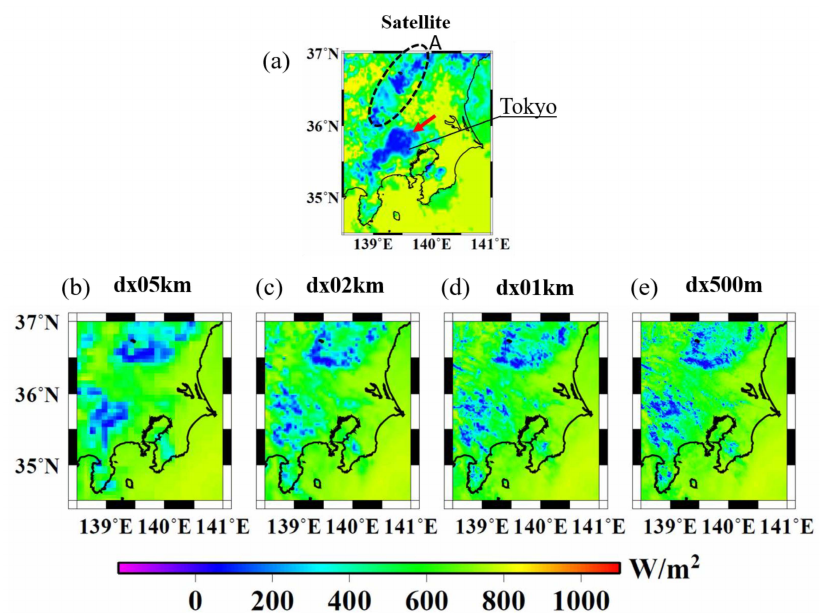
Figure 8. Comparison of the GHI horizontal distributions between the satellite observations and simulations. ( a ) Satellite-derived GHI distributions for the TEPCO area at 14 JST on 30 July 2015. GHI forecasts (5 h ahead forecast) obtained from ( b ) dx05km, ( c ) dx02km, ( d ) dx01km, and ( e ) dx500m with 00 UTC (09 JST) initialization time. The red arrow in ( a ) indicates the location of the target cumulus clouds.